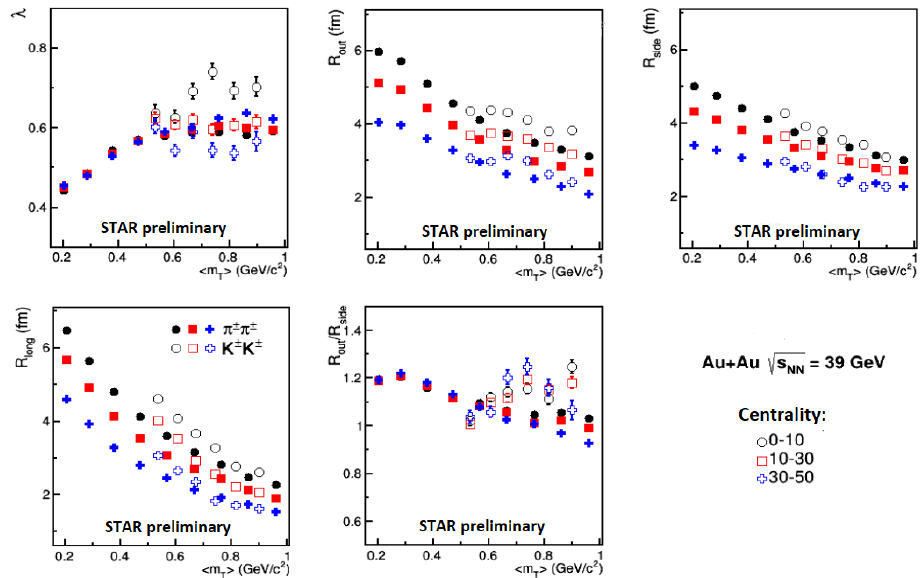
Figure 2. Transverse mass dependence of λ , R out , R side , R lon g and R out / R side for pions (solid symbols) and kaons (open symbols) measured for 0–10% (circles), 10–30% (squares), and 30–50% (crosses) √ s NN = 39 GeV. Only statistical uncertainties most central Au + Au collisions at